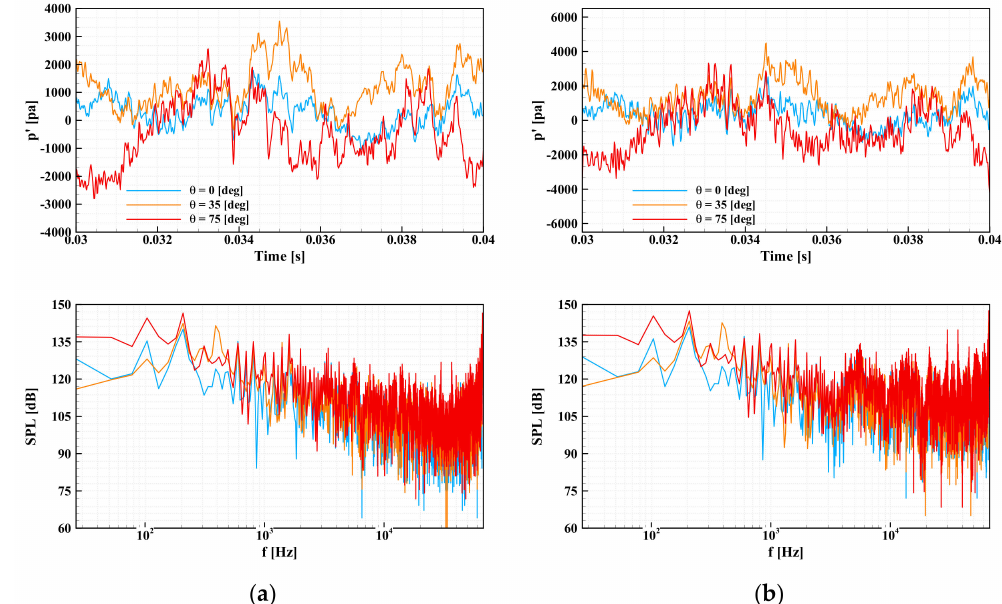
Figure 13. Acoustic pressure fluctuation and sound pressure level on the fuselage: ( a ) on the nose; ( b ) on the